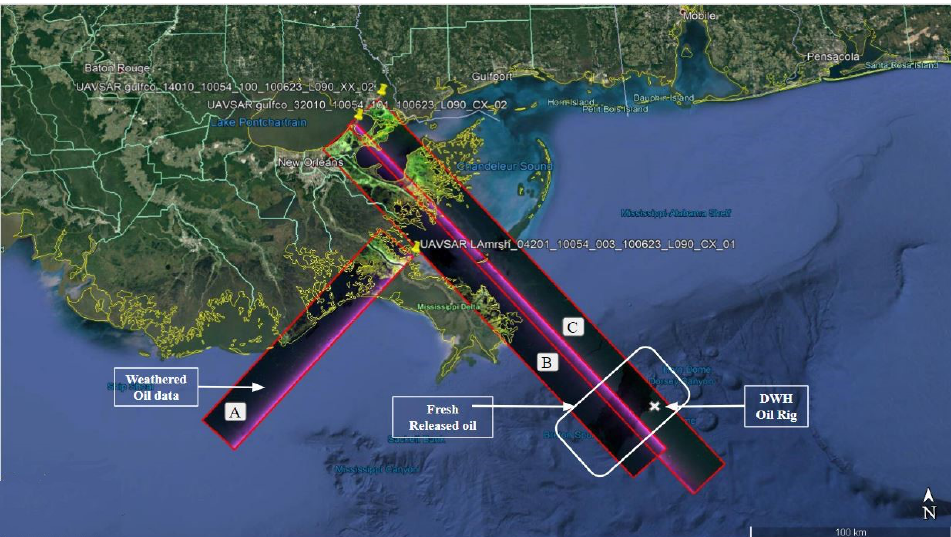
Figure 4. Study area: ( B , C ) UAVSAR L band multi-polarization images of main slick of DWH spill- gulfco_14010 (23 June 2010 20:42 UTC) and gulfco_32010 (23 June 2010 21:08 UTC). ( A ) UAVSAR multi-polarization images of Barataria Bay (BB), Lousiana and the barrier islands at the entrance to BB; BB is in the upper part of the image – Lamrsh_04201 (23 June 2010 23:05 UTC).The colors are a composite of the HH-polarization intensity image (red), the VV (black) and the HV (green).